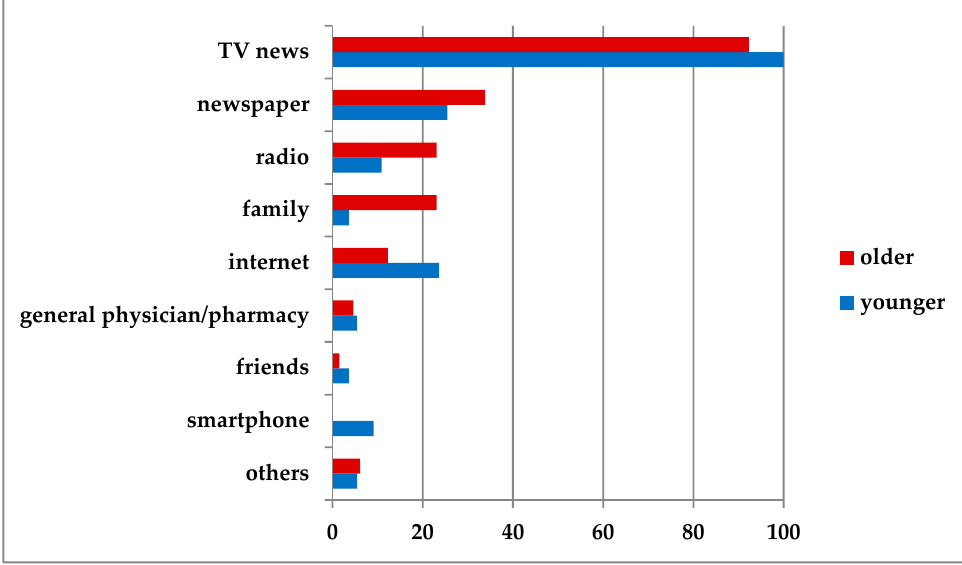
Figure 1. Actively reported sources of information (%). Active reporting means that patients were not given a choice of answers but were free to choose their own.